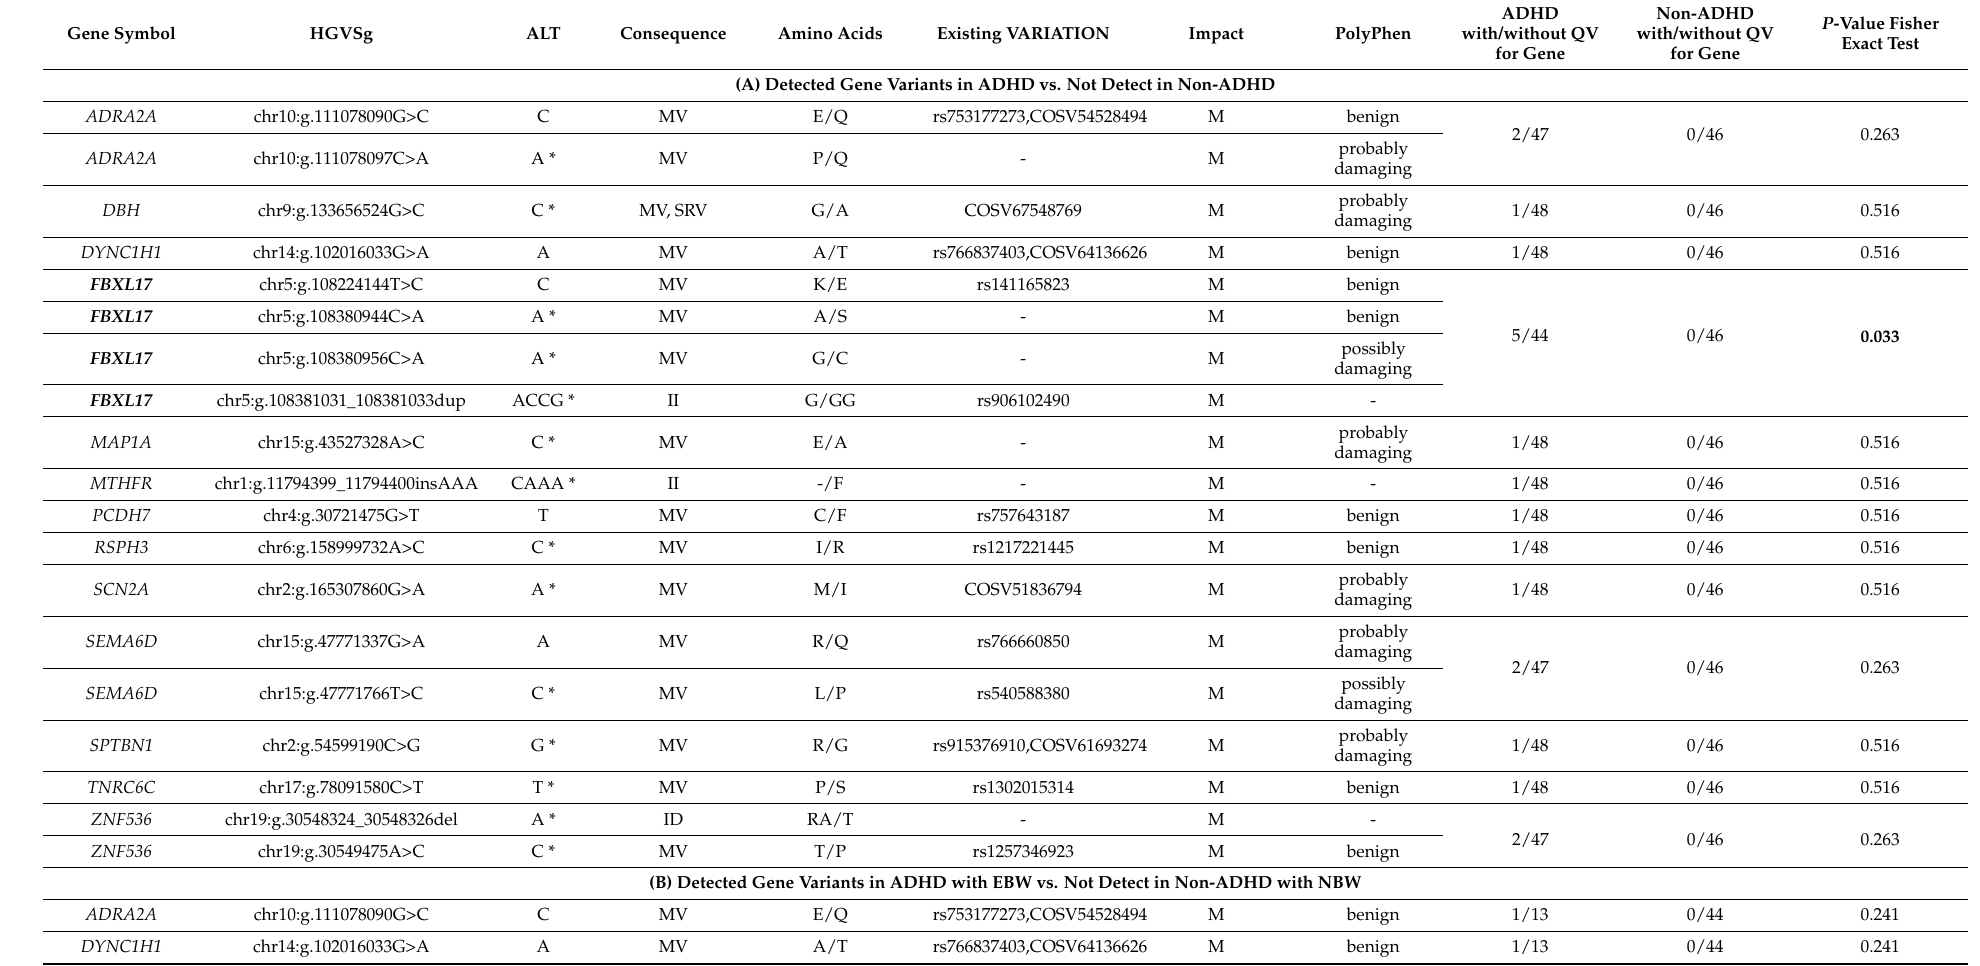
Table 4. List of genes with identified gene